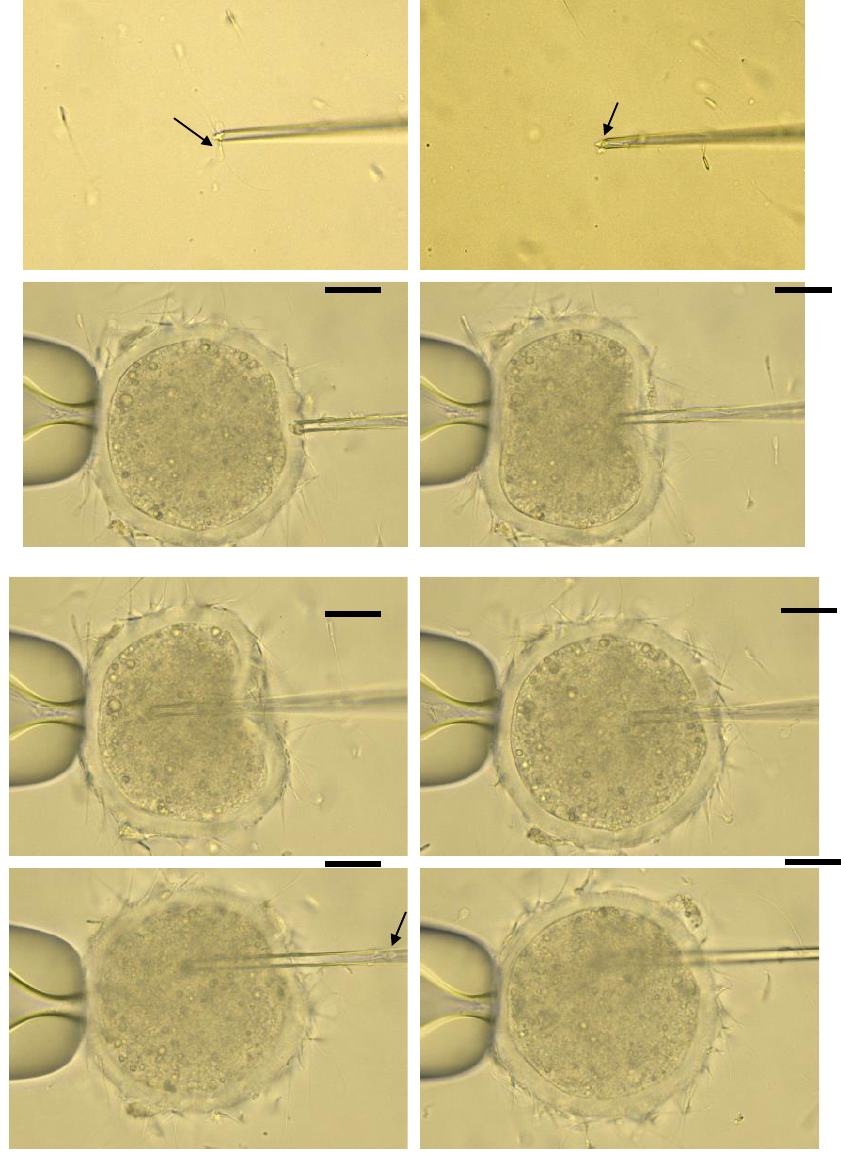
Figure 5 . Intracytoplasmic sperm injection (arrow: spermatozoon,